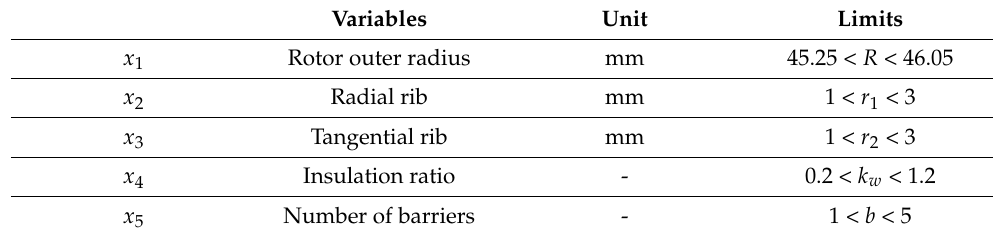
Table 2. Maximum and minimum range.